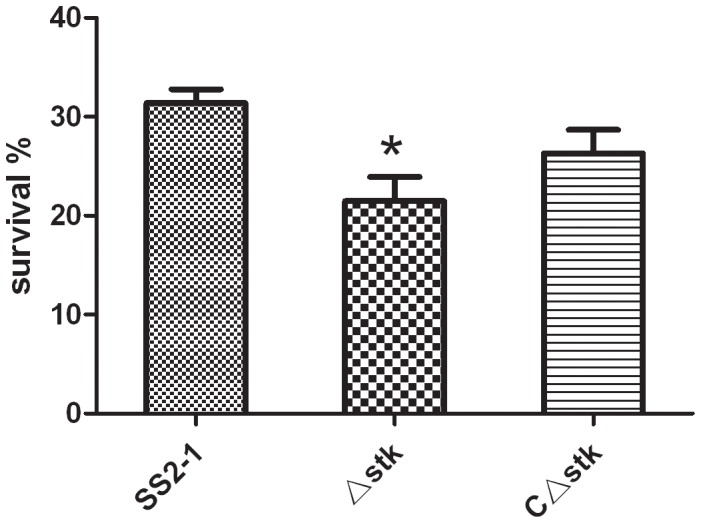
Survival of SS2-1 and Δstk in pig whole blood.Mixtures were incubated at 37°C for 2 h. A value of 100% was given to the CFU at time 0 h. The percent survival rate of Δstk significant reduced compared to SS2-1. (p = 0.0283).